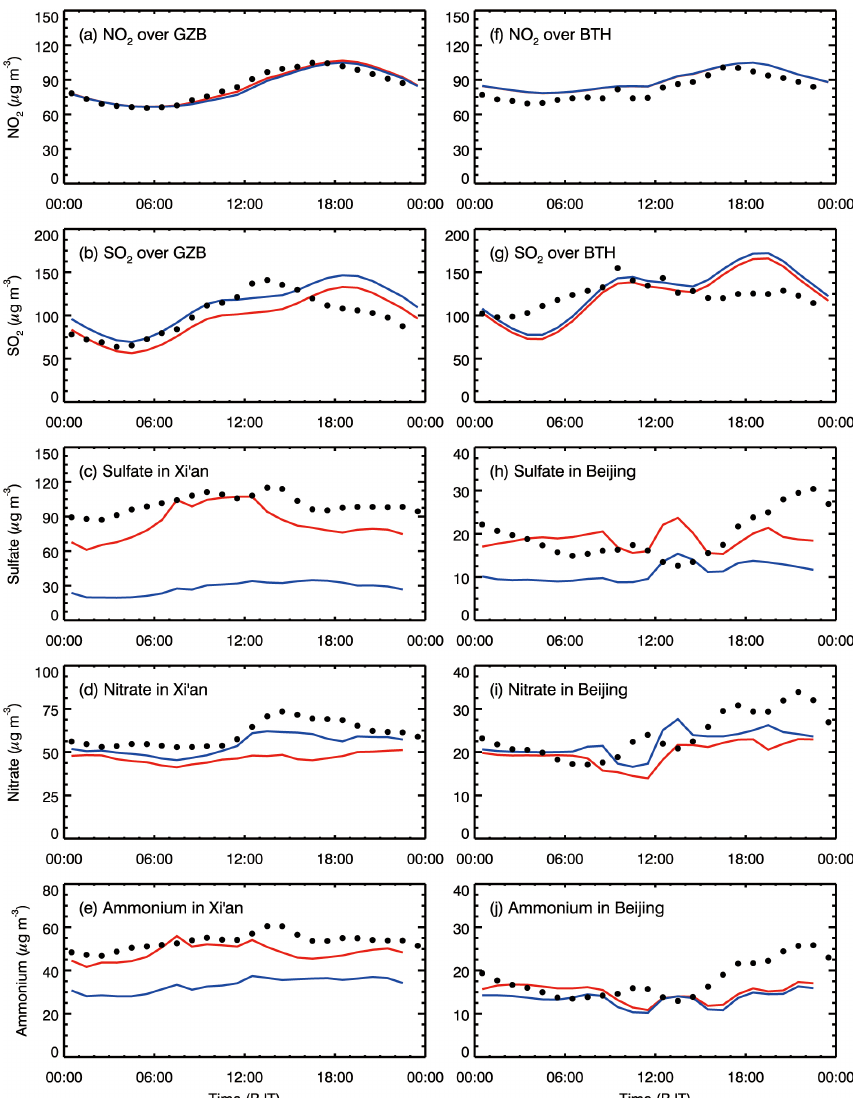
Figure 14. Observed and simulated diurnal cycles of mass concentrations of NO 2 and SO 2 averaged over GZB and BTH and the sulfate, nitrate, and ammonium aerosols in Xi’an and Beijing during the simulated